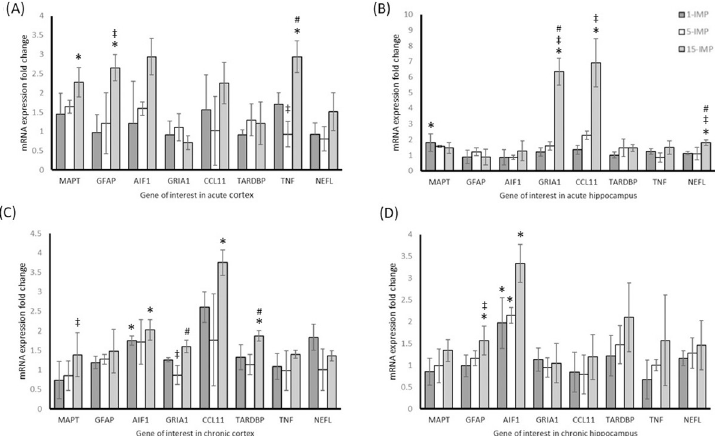
Fig 6. Repetitive mTBI induces upregulation of neurodegenerative genes. (A) mRNA expression fold change relative to sham control of eight genes in the cortex at acute testing. (B) mRNA expression fold change relative to sham control of eight genes in the hippocampus at acute testing. (C) mRNA expression fold change relative to sham control of eight genes in the cortex at chronic testing. (D) mRNA expression fold change relative to sham control of eight genes in the hippocampus at chronic testing. Normalised to Gapdh ( ± SD). � p < 0.05 difference compared with sham control; ‡ p < 0.05 difference with 1-IMP; # p < 0.05 difference compared with 5-IMP. N = 4 per group.